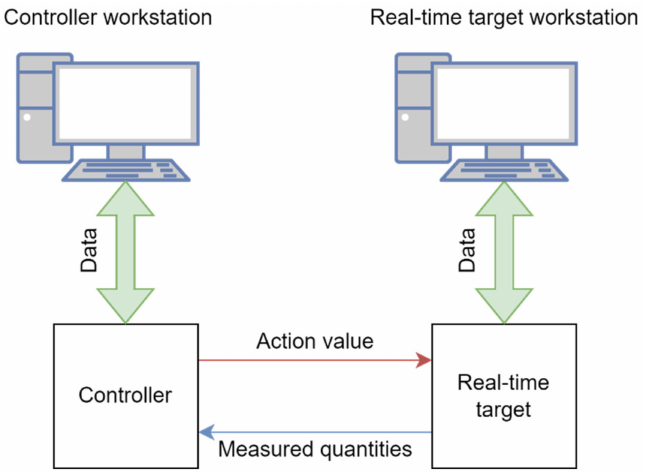
Figure 2. Hardware-in-the-Loop general